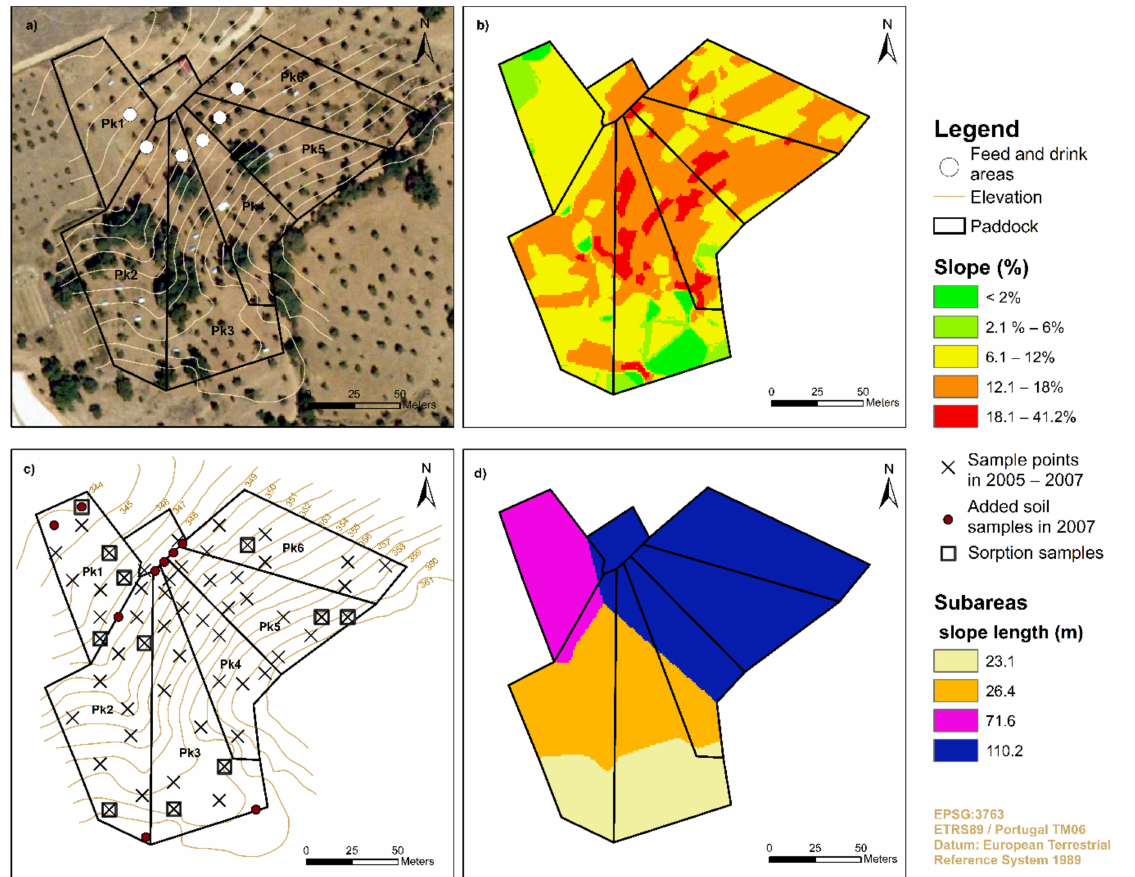
Figure 1. Outdoor pig production area, ( a ) paddocks, feeders and well points, ( b ) slope (%), ( c ) soil sample points and elevation of the area, and ( d ) homogenous areas with similar slope length